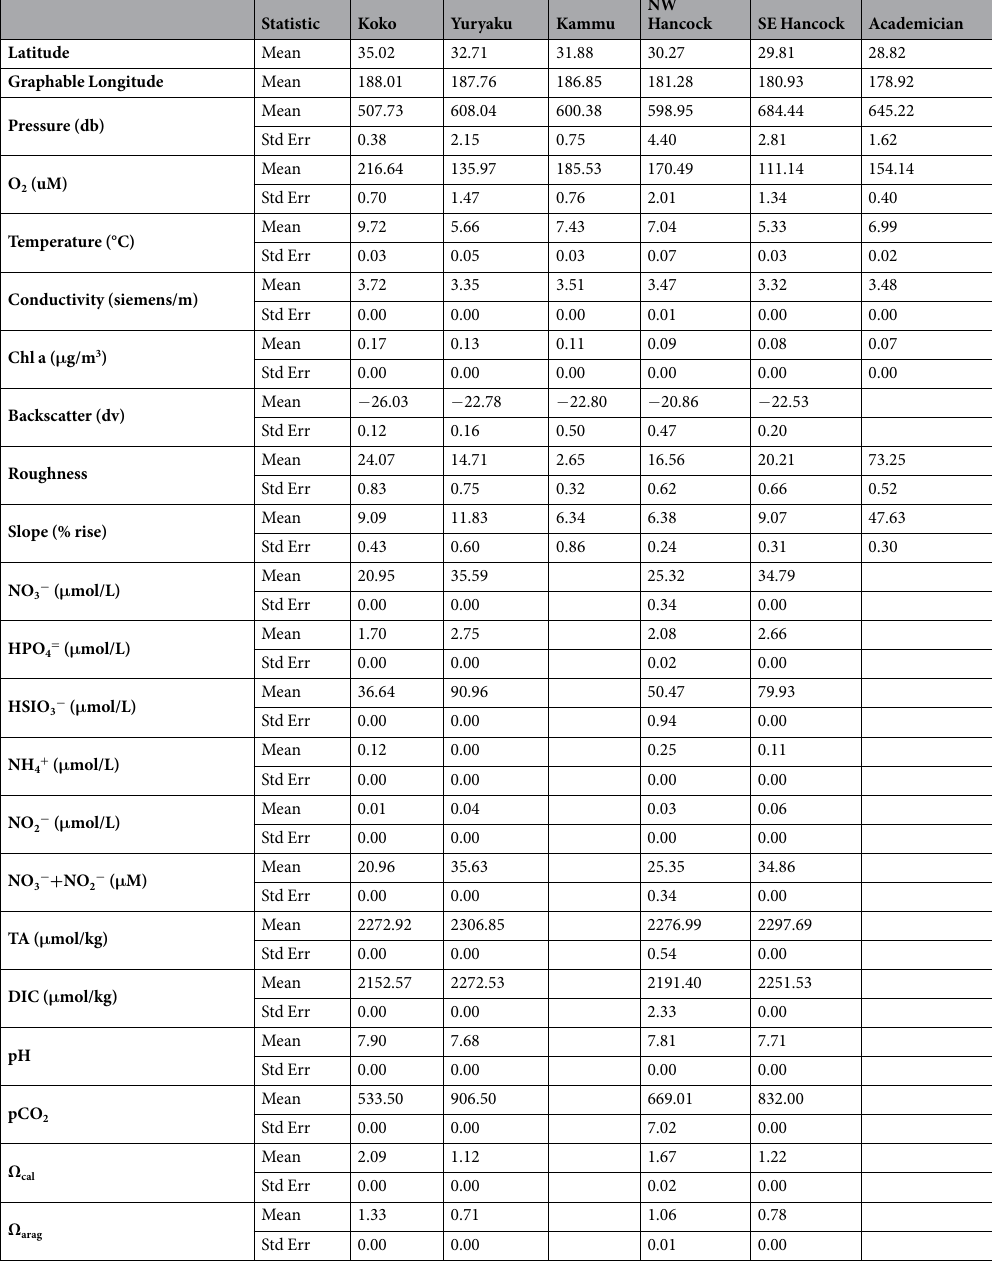
Table 2. Summary of available environmental data for each seamount in this study at the sites where scleractinians were observed, including both transect and non-transect